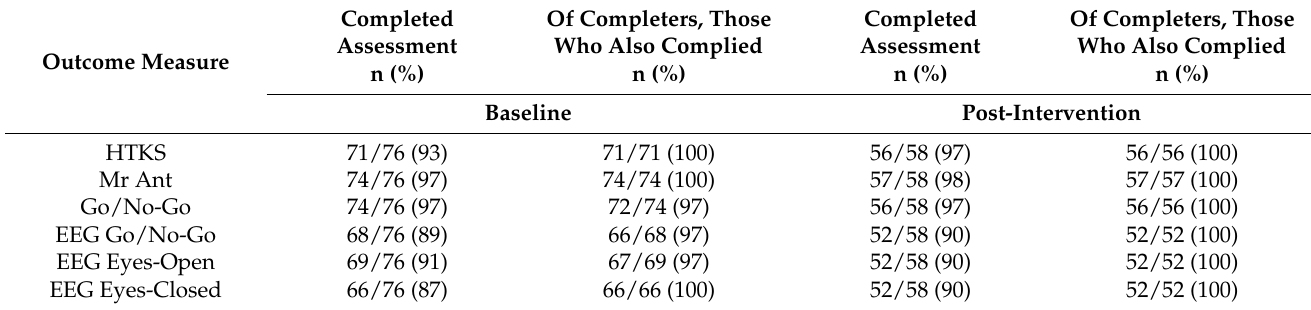
Table 5. Completion rate of outcome measures and compliance with tasks by